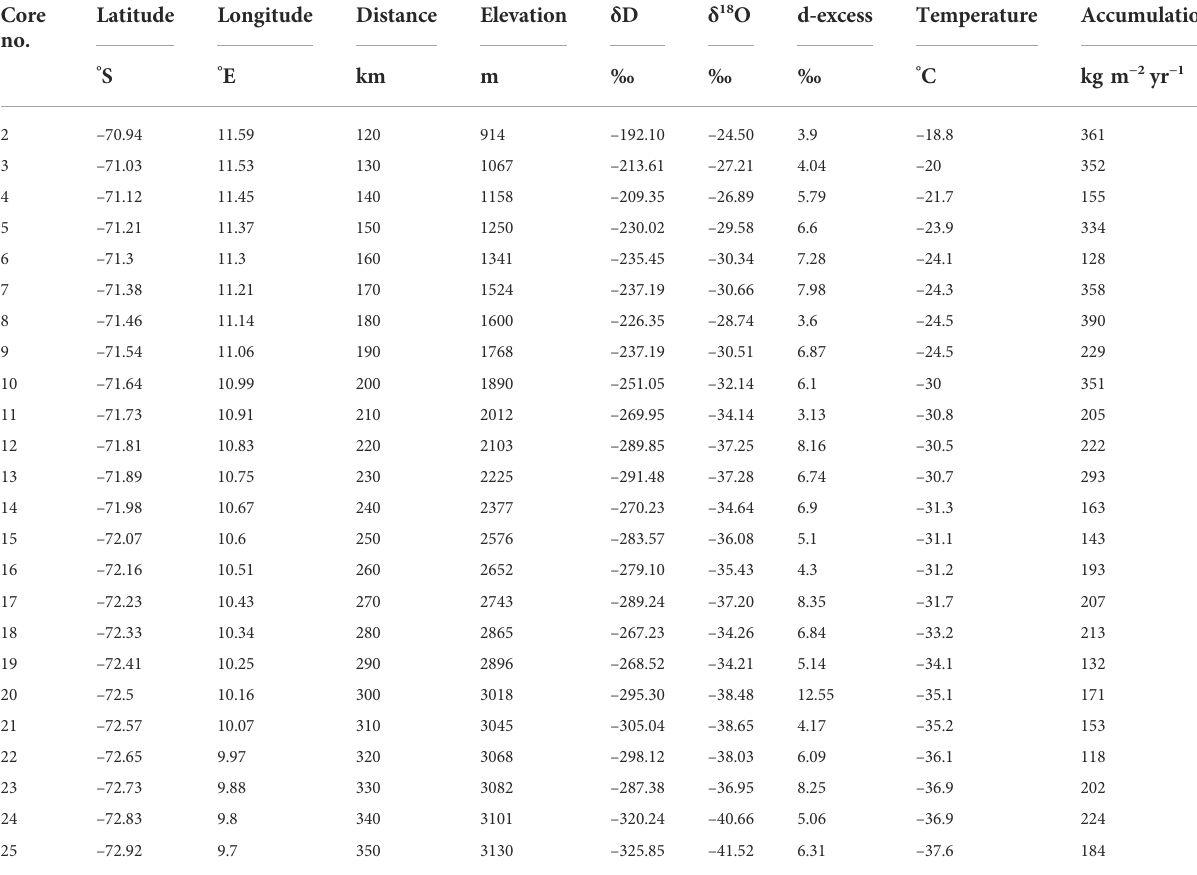
TABLE 1 Geographical distribution and annual-averaged stable isotope values and accumulation rates (w.e) of the snow cores from DML region. Annually averaged temperature estimates for the year 2008 was taken from ERA-5. The distance column shows the distance measured from the